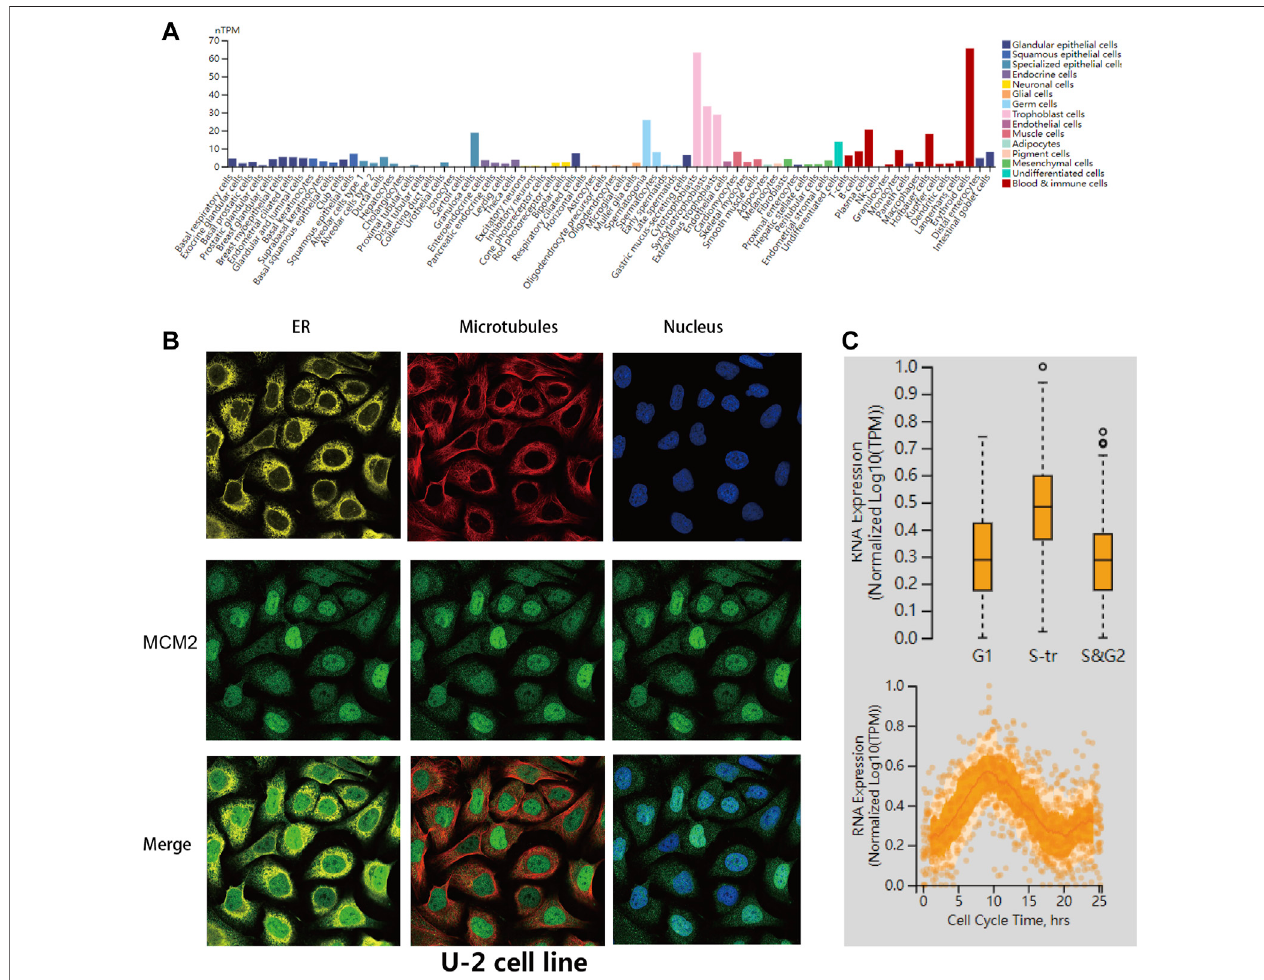
FIGURE 3 | MCM2 variants, localization and single-cell variations. (A) MCM2 expression in normal cell lines from the HPA database. (B) Subcellular distribution of MCM2 within the endoplasmic reticulum (ER), nucleus and microtubules of the U-2 cells lines, according to the HPA database. (C) Plots of single-cell RNA-sequencing data from the FUCCI U-2 cell line showing the correlation between MCM2 RNA expression and cell cycle progression.